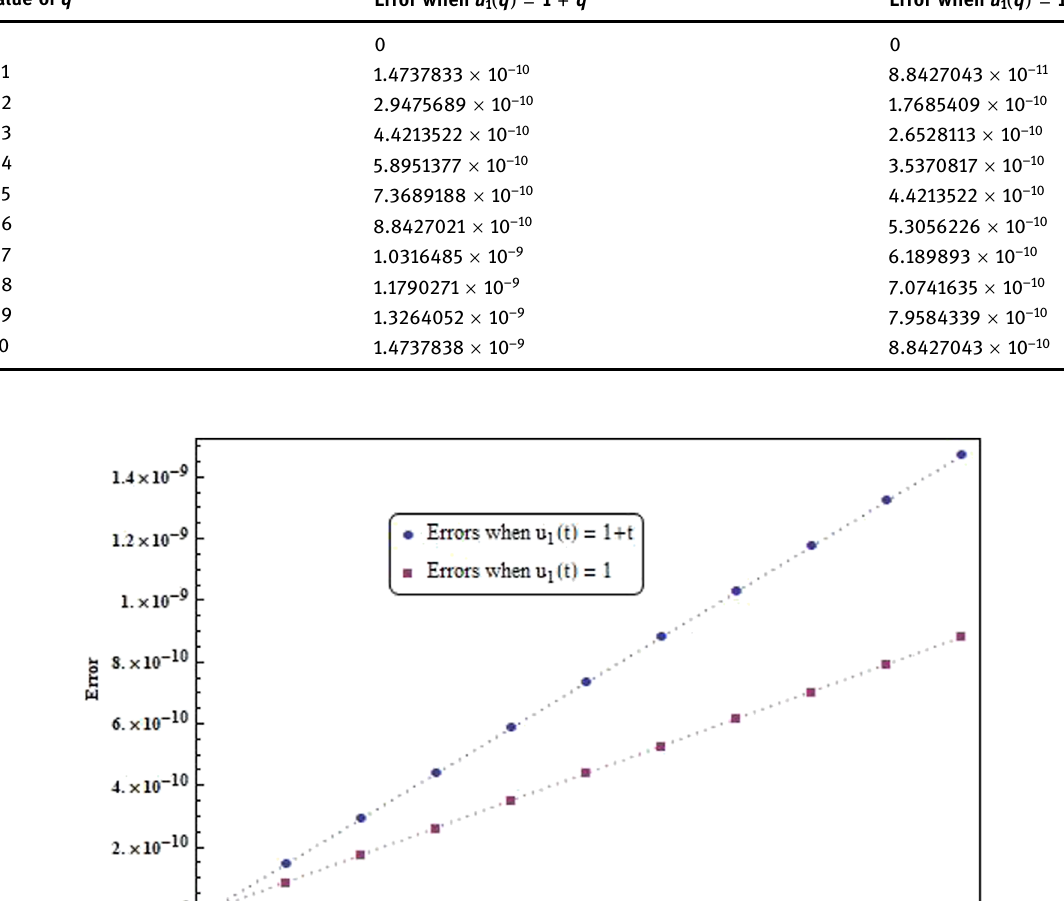
Table 5: Error for di ff erent approximated values and the exact solution Value of q